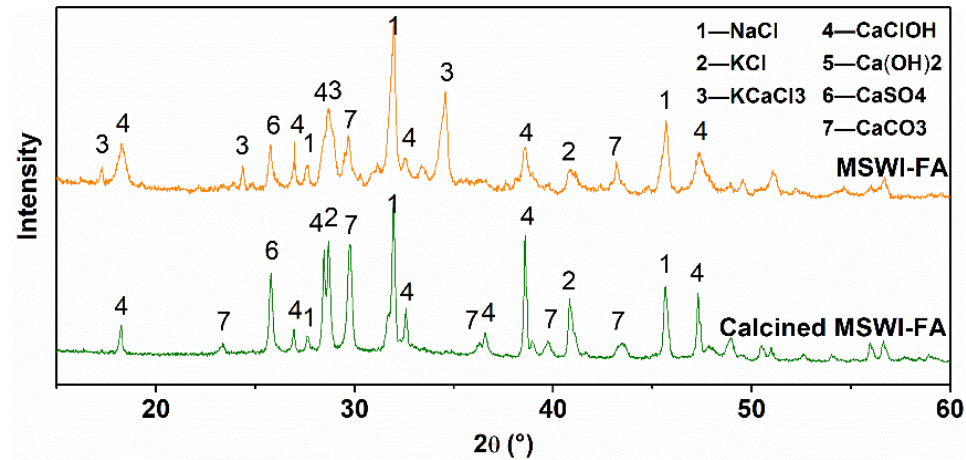
Figure 3. XRD patterns of MSWI fly ash and calcined ash.